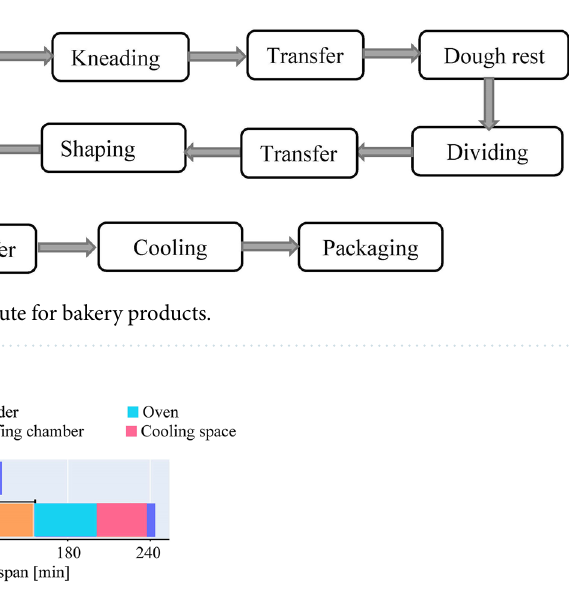
Figure 2. Gantt chart showing schedule of one product group with unified initial stages. The triangle (∆) shows the oven idle